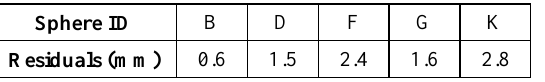
Table 8. Georeferencing residuals of five